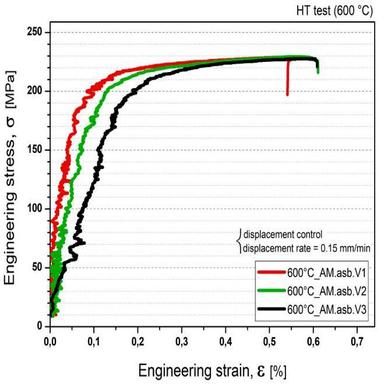
Static engineering stress-strain curves at 600 ◦C for Vertical specimens produced by LPBF and tested as built.